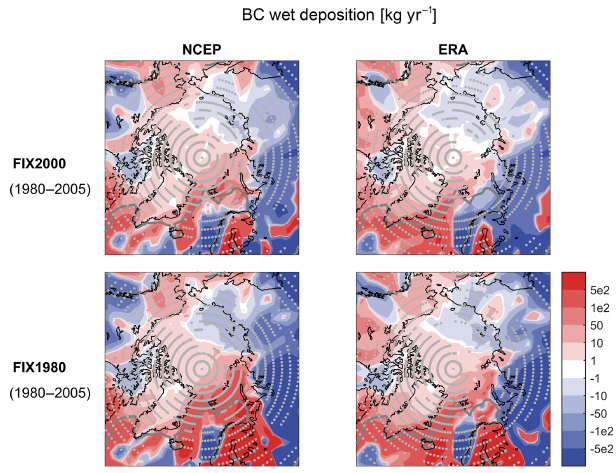
Figure 11. Four different estimates (see also Table 1) of to- tal trends of maximum likelihood BC wet deposition (kgyr − 1 ) associated with three atmospheric circulation patterns (To- tal = NAO + SB + ENSO). The grey line represents the mean win- ter sea ice and snow cover larger than 50% from 1980 to now. Grey dots represent the grid points with trend significant at 5%